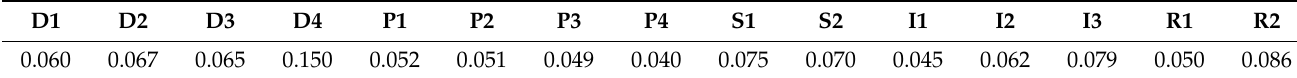
Table 3. Weights of each DPSIR